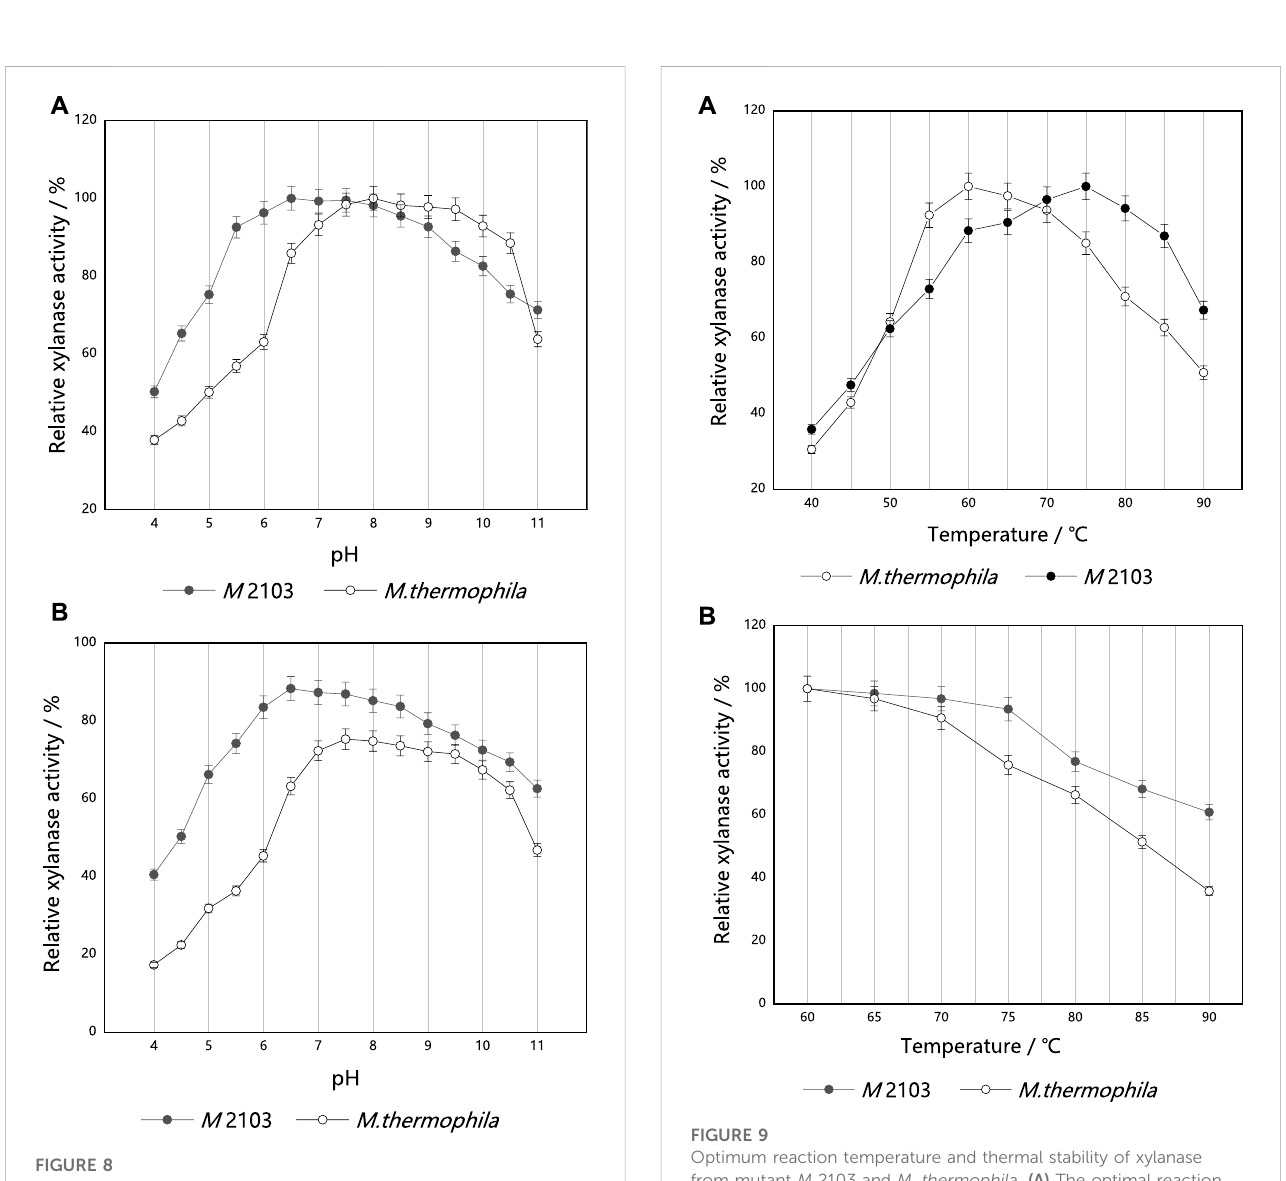
Optimum reaction temperature and thermal stability of xylanase from mutant M 2103 and M. thermophila . (A) The optimal reaction temperature of xylanase from mutant M 2103 and M. thermophila (B) Thermal stability of the xylanase from mutant M 2103 and M. thermophila. All experiments were carried out four times (biological duplicates and technical duplicates) and mean values presented with standard